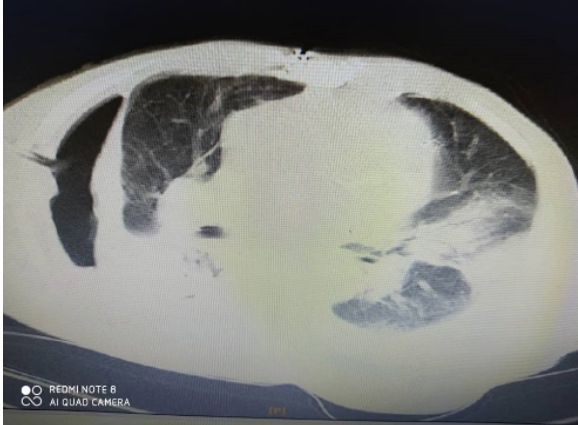
Figure 1. CT scan of the patient's lungs